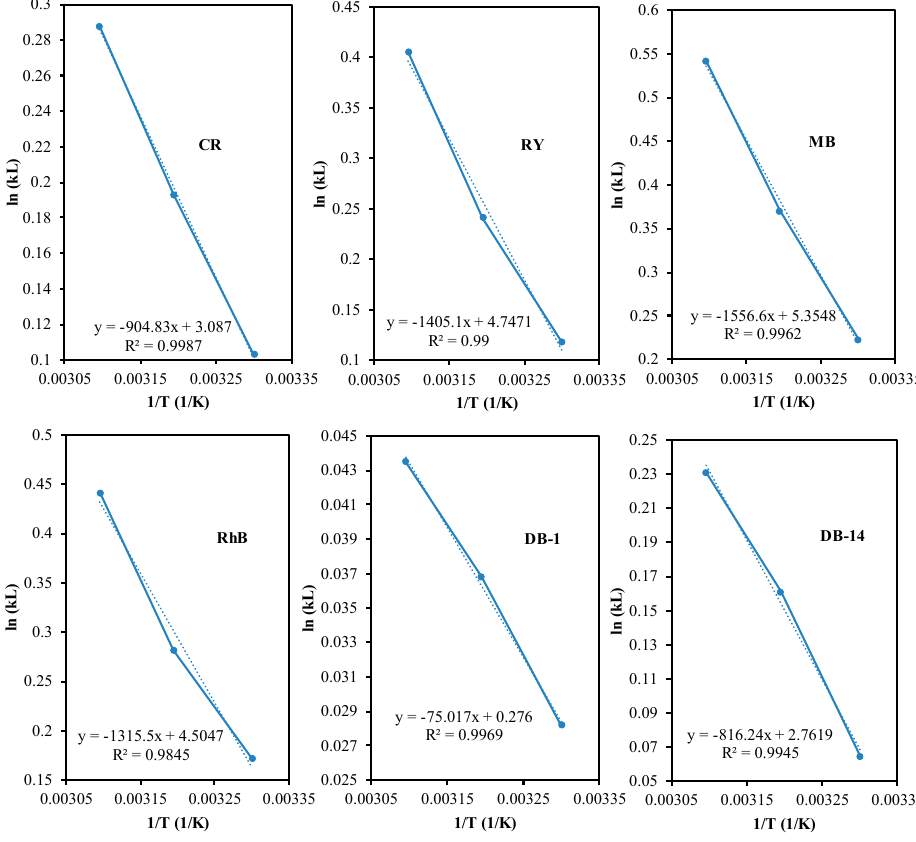
Figure 6. Graph plot of 1/ T vs. ln k L .